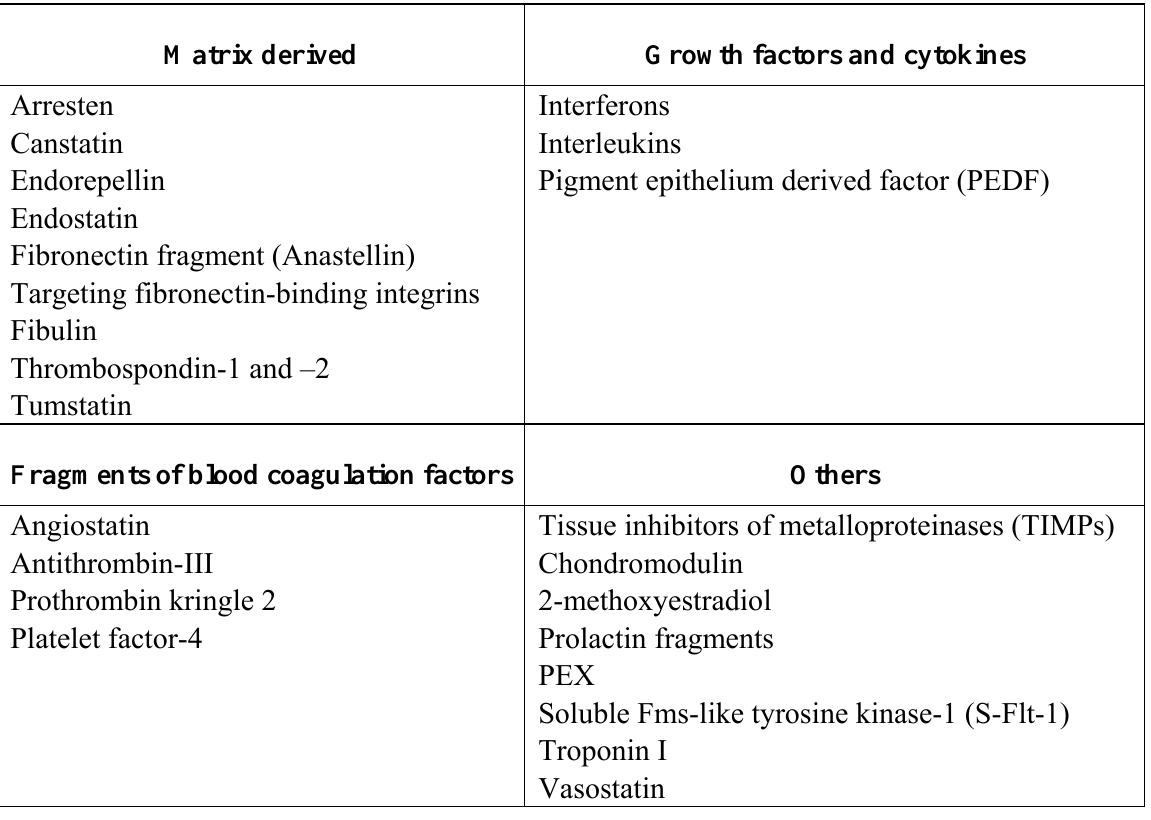
Table 2. Endogenous inhibitors of